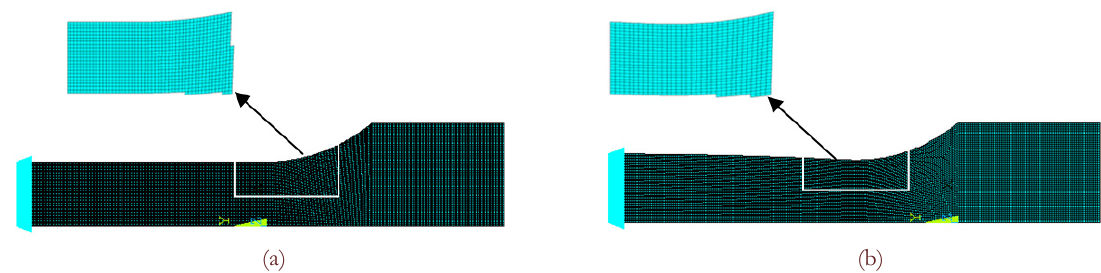
Figure 2: Typical mesh for the specimen models: (a) dog-bone specimen; (b) Gaussian specimen.